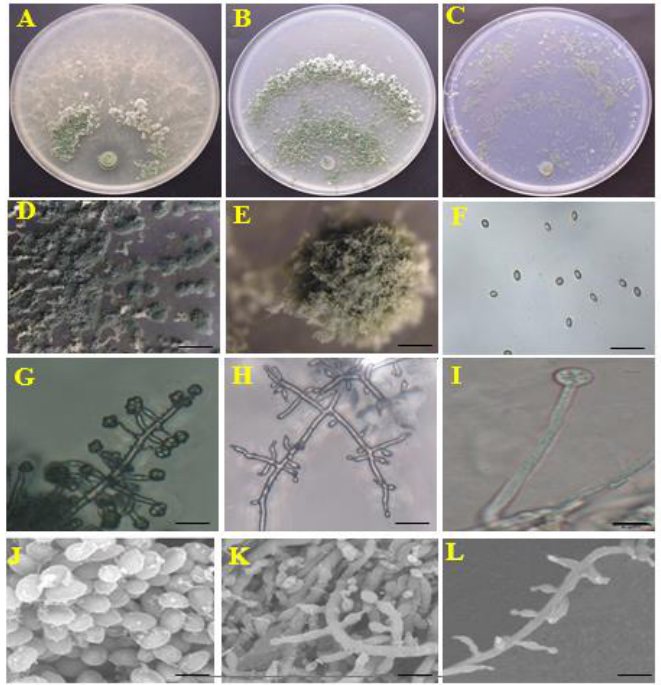
Figure 3. Morphological characteristics of Trichoderma HL167. ( A – C ) showed the growth appearance of Trichoderma strain HL167 cultured on PDA, SNA, and CMD media; ( D – I ) displayed the morphological characteristics of the colony, conidia, hyphae, conidiophore, and chlamydospore on the PDA medium, respectively; ( J ) is the morphological characteristics of the conidia of Trichoderma strain HL167 under the electron microscope; ( K ) and ( L ) show the morphological characteristics of the hyphae of Trichoderma strain HL167 under the electron microscope. Scale bars: ( D ) = 2 mm, ( E ) = 500 µ m; ( F , G ) = 10 µ m; ( H ) = 20 µ m; ( I ) = 5 µ m; ( J ) = 20 µ m, ( K , L ) = 6 µ m.